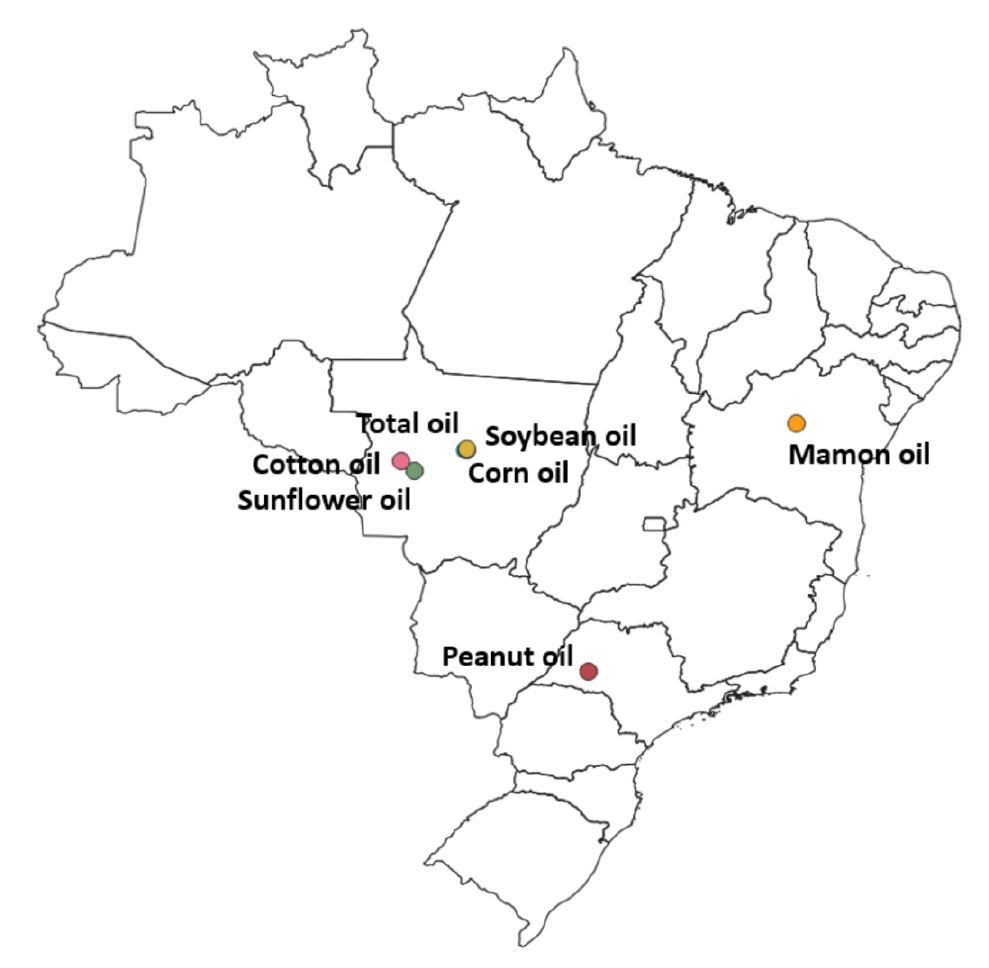
Figure 10. SVO hotspots in